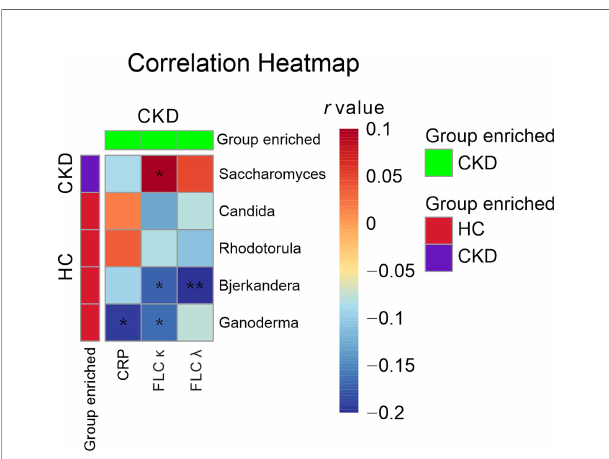
FIGURE 3 | Gut mycobiome correlation to immunological pro fi les. Spearman correlation analysis was performed on the abundant bacterial genera (>1% relative abundances) that displayed a signi fi cant difference between CKD patients and HCs and the disease pro fi les that showed signi fi cant difference between CKD patients and HCs. The correlations of two variables with values of P < 0.05 are displayed. *, and ** indicate P < 0.05 and P < 0.01